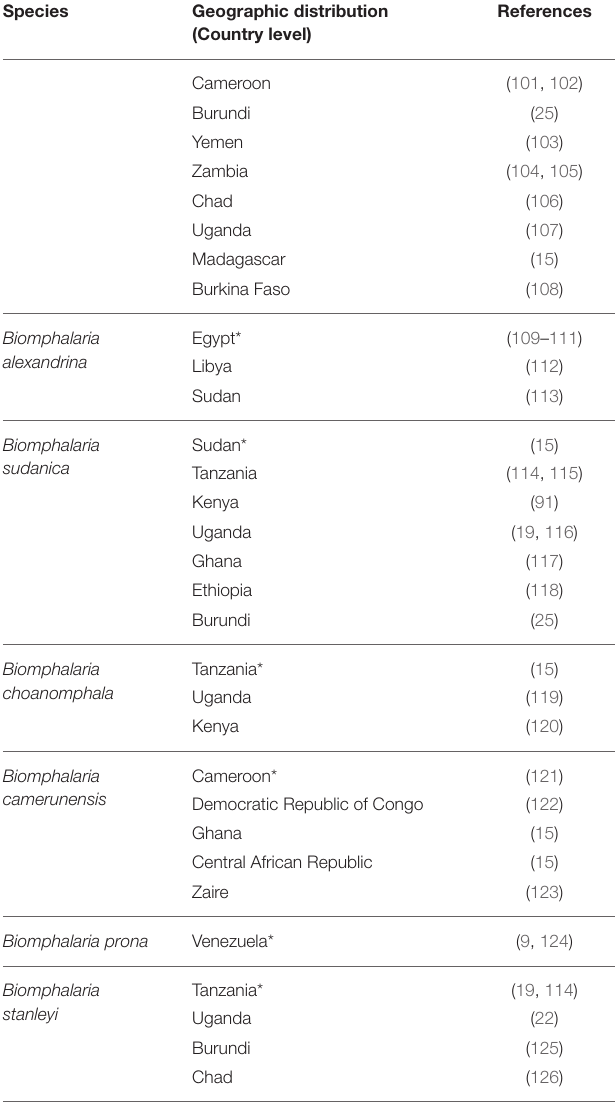
* Indicates first record of the species.